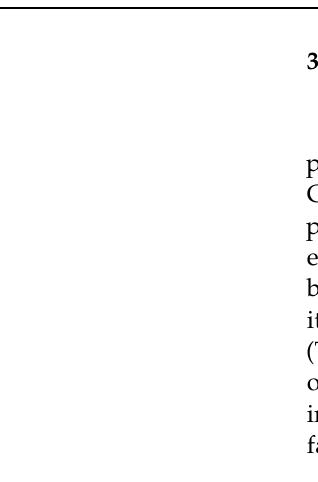
Table 2. Differential diagnosis of proteinuria and hematuria in early pregnancy in our